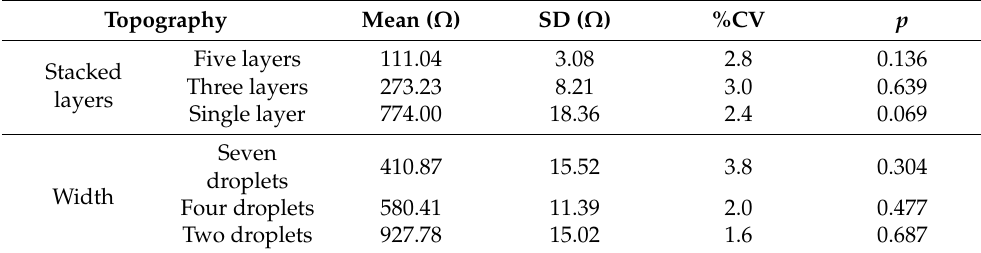
Figure 3. ( a ) Design of the printed strain gauge. ( b ) Resistance variations of the printed strain gauges. Blue and orange bars are for stacked layers and different widths, respectively. Data are mean and standard deviation values. Table 1. Statistical evaluation of measured resistances of the printed strain-gauge patterns.